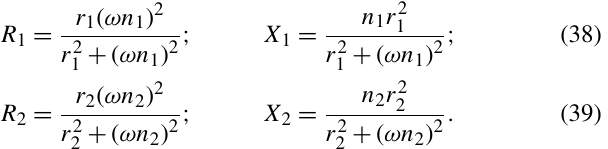
Figure 14. Transformation of the circuit model without external interaction (a) into a complex impedance Z : (b) conversion of r – n - parallel in series circuit, (c) combination of parallel branches into a complex impedance Z p , (d) summation of R 1 , X 1 and Z p to Z .